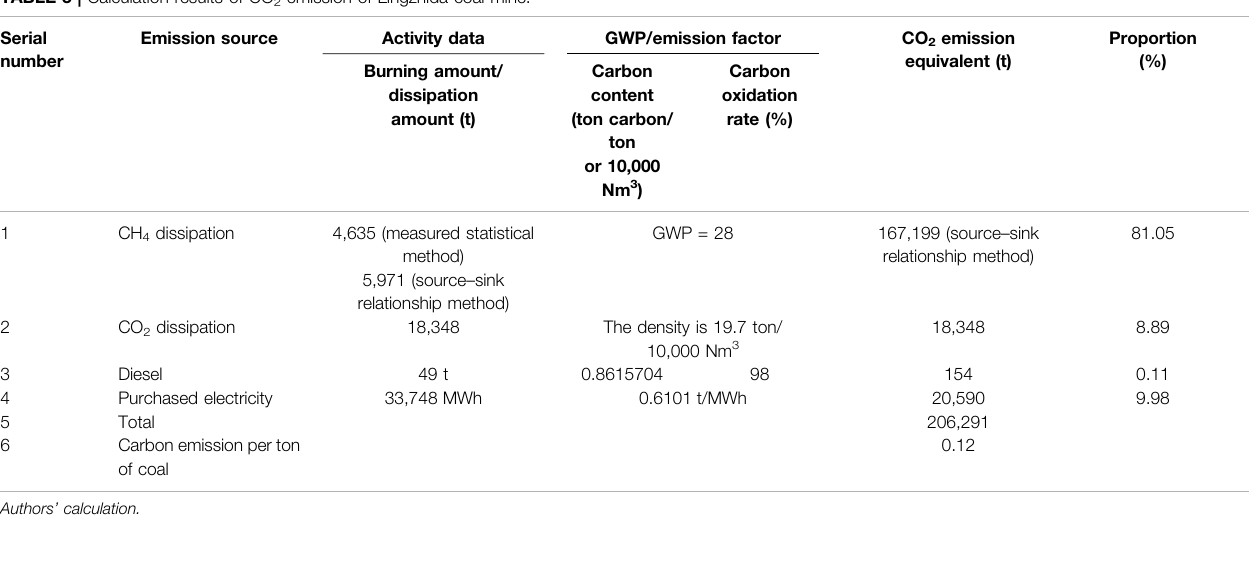
TABLE 3 | Calculation results of CO 2 emission of Lingzhida coal mine.